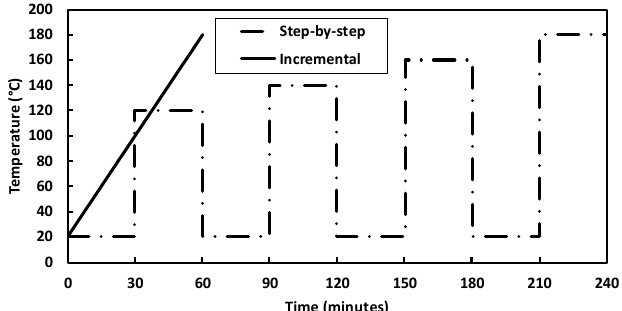
Figure 3. Schematic representation of the heating process for test series 1 (step-by-step) and series 2 (incremental).